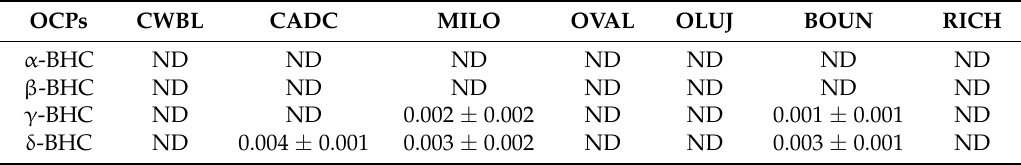
Table 3. Mean concentration (mg/kg) of dichlorodiphenylethene in the cocoa beverages.